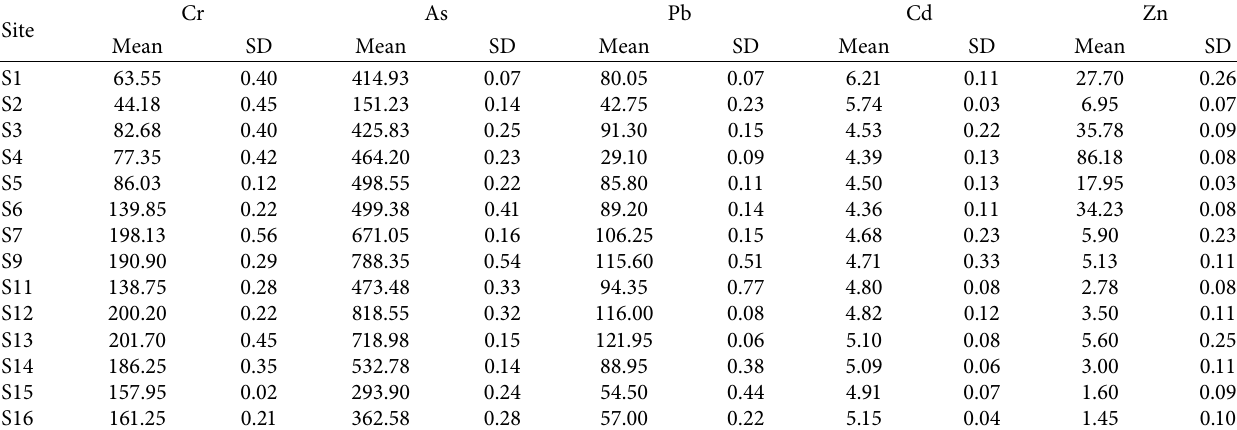
Table 3: The concentrations of heavy metals in the sediments of Huangshui River (mg · kg − 1